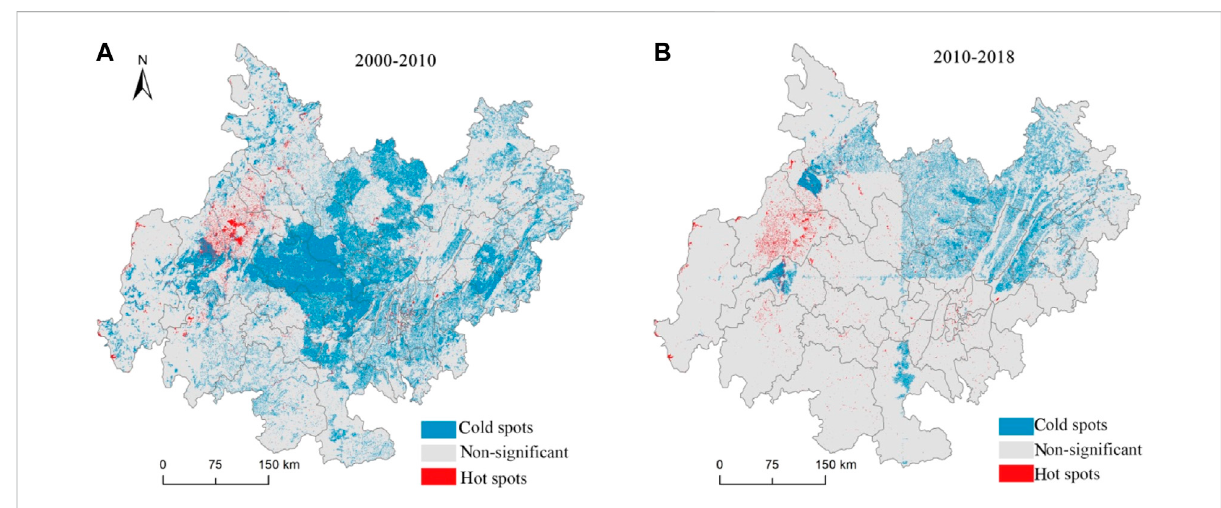
FIGURE 7 (A – B) represents the spatial distributions of hot spots of land use transitions of two phase in the Chengdu-Chongqing